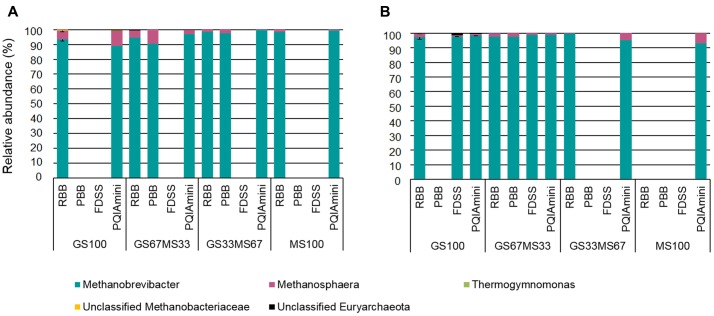
Relative abundance of archaeal taxa at genus level within rumen fluid (A) and fibrous content (B) samples from dairy cows each fed different ratios of grass silage (GS) to maize silage (MS), e.g., GS67MS33 is a diet containing 67% grass silage and 33% maize silage. All samples were subjected to each of the four different DNA extraction methods (RBB, PBB, FDSS, and PQIAmini). Missing bars indicate that it was not possible to generate an archaeal PCR product for sequencing. Error bars for the GS100 samples represent the standard deviation associated with two different extracts, except for the PQIAmini extracted GS100 rumen fluid sample (A) where n = 1.